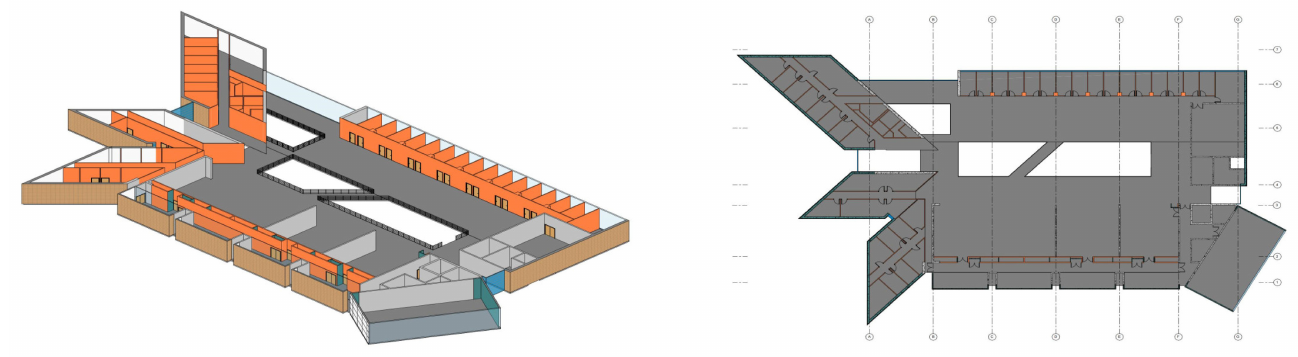
Figure 3. TETB BIM model and typical floor